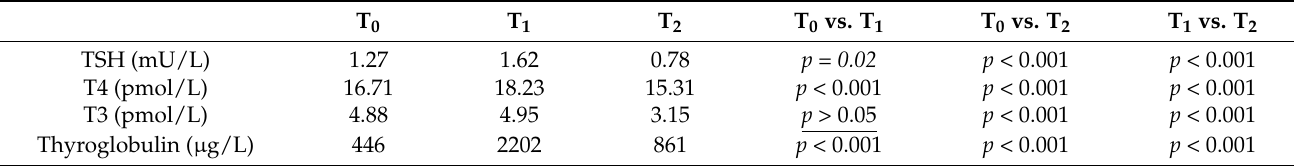
Table 3. Mean levels of TSH, T4, T3, and thyroglobulin perioperative in subgroup I ( n = 50). T 0 T 1